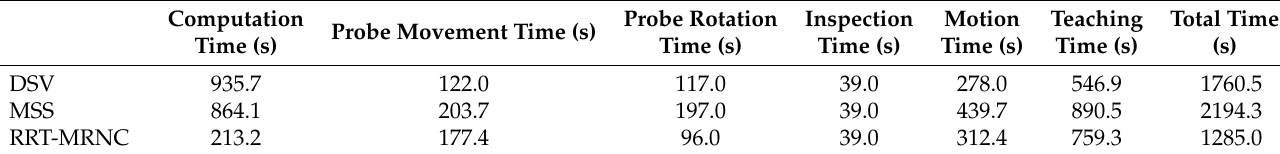
Table 3. Comparison of planning results by different